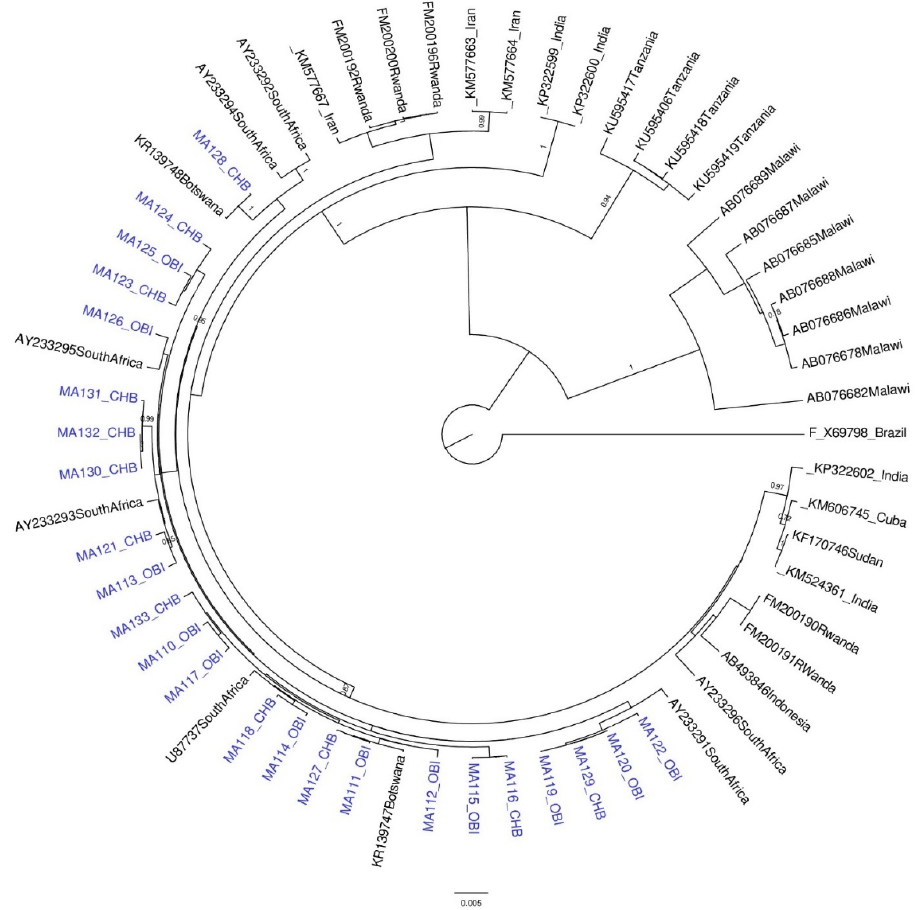
Figure 2. A phylogenetic tree of the whole surface region (nt 2854–835 from Eco RI site) of HBV subgenotype D3 generated by BEAST. Botswana sequences are shown in blue, whereas reference sequences are in black. Reference strains are designated by their accession number and country of origin, whereas Botswana sequences are designated by MA followed by a number and either CHB or OBI.